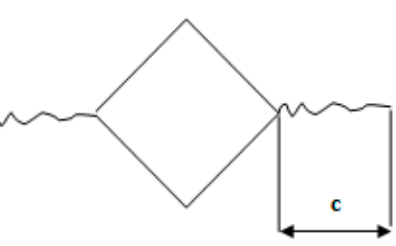
Figure 1. The crack length that occurred in the coating (c).